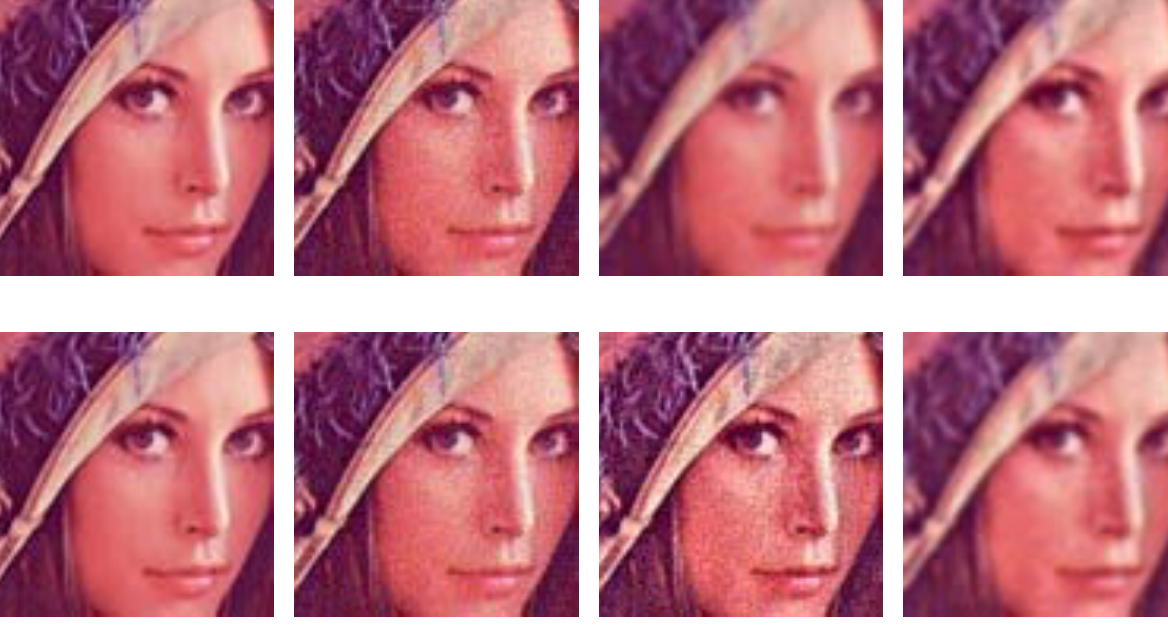
Fig. 8 First row, original image, original image blurred with Gaussian noise with σ = 10, filtered image with BF and finally ouput of BF and posterior CLAHE. Second row, original and noisy image, the enhanced image with CLAHE and finally output of CLAHE and posterior